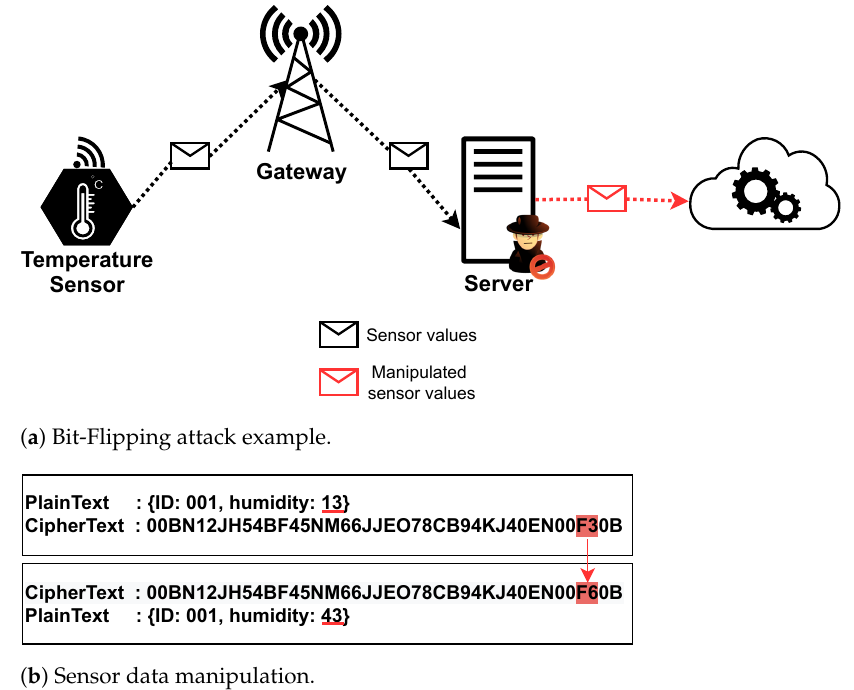
Figure 7. Bit-Flipping attack example with manipulated sensor data. Adapted from